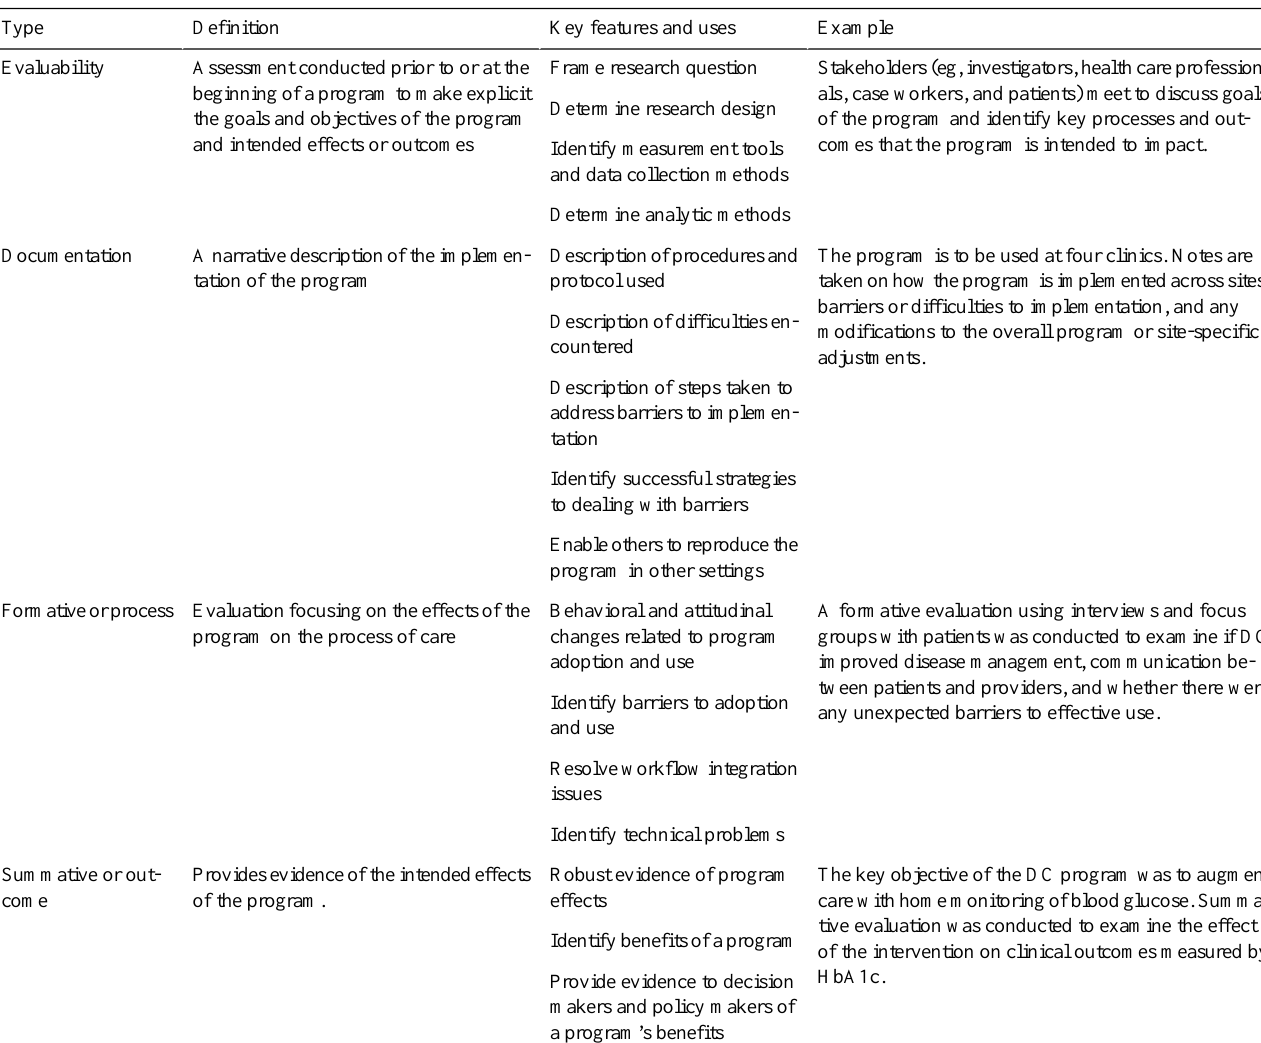
Table 1. Evaluation